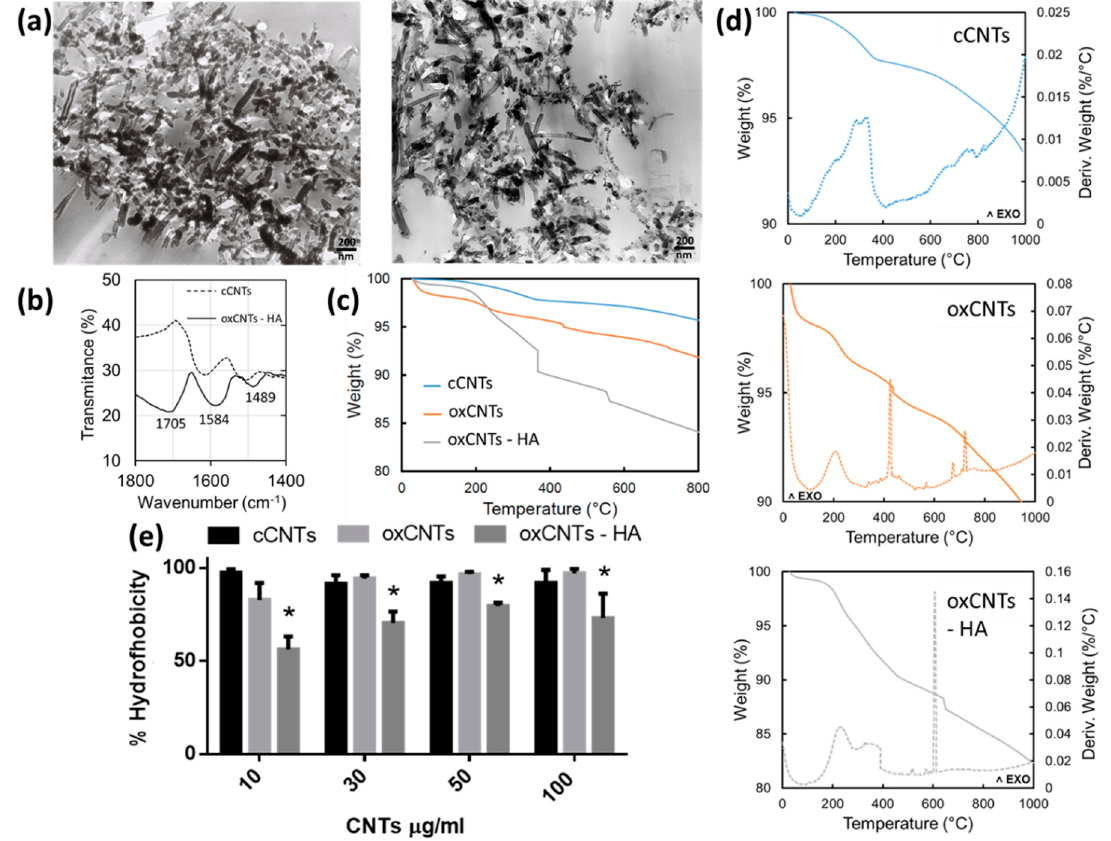
Figure 1. Physical characterization for as prepared nanovectors. In panel ( a ) is shown the electron micrographs cCNTs ( left ) and oxCNT’s-HA-CPT (right). FTIR spectra of cCNTs (dotted line) and oxCNTs-HA (solid line) showing the most representative bands in the range from 1800 to 1400 cm − 1 ( b ). Thermogravimetric analysis in conjunction with di ff erential scanning calorimetry curves are showed in figures ( c , d ), respectively. Finally, the hydrophobicity index is shown in ( e ) ( Bars indicate the mean ± SD, n = 5, * p < 0.05).